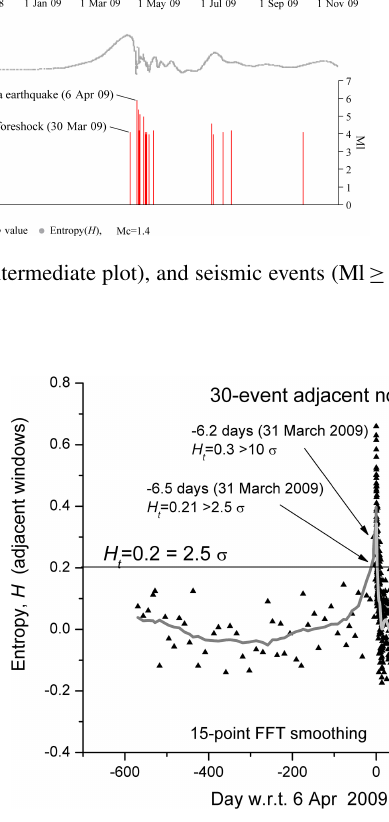
Figure 11. Shannon entropy for L’Aquila seismic sequence from around 1.5 year before the mainshock to around 1 year after, calcu- lated for a circular area of 80km around the mainshock epicenter. The gray curve defines a reasonable smoothing of the entropy val- ues: 15-point FFT before the mainshock and 50-point FFT smooth- ing after the mainshock. Sigma is the standard deviation estimated over the whole interval (w.r.t means with respect